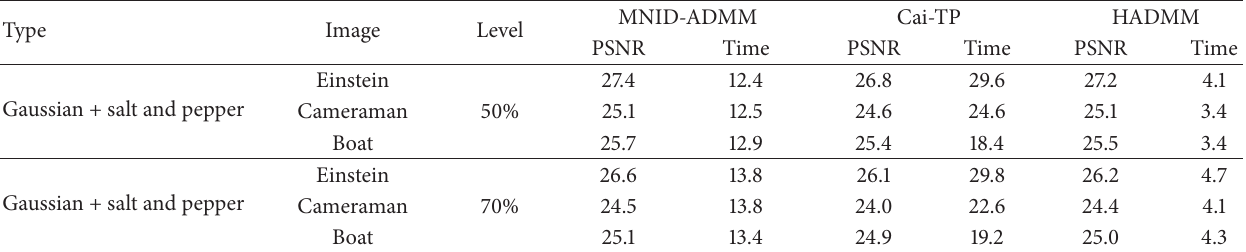
Table 3: The PSNR (dB) and computing time (seconds) for the restoration results by MNID-ADMM, Cai-TP, and HADMM for blurred images contaminated by Gaussian noise ( 𝜎 = 5) plus salt-and-pepper noise. The blurring kernel is the out-of-focus kernel of radius 3.